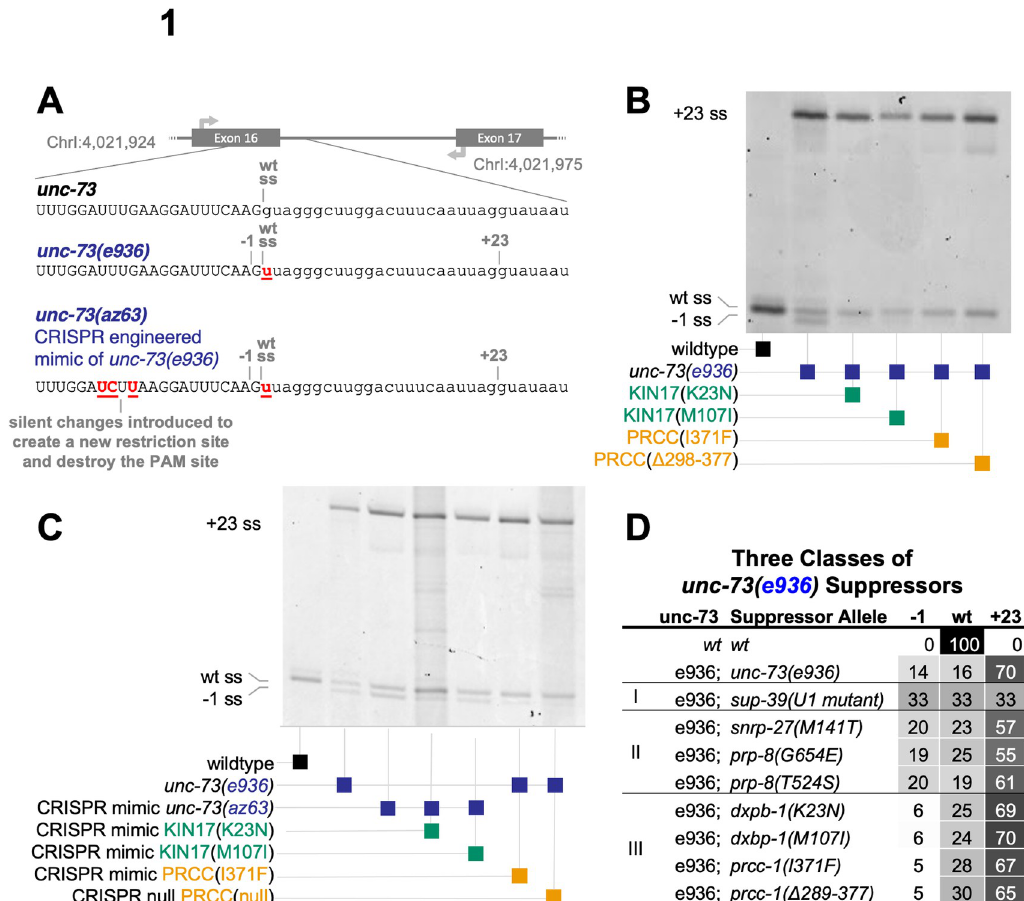
Fig 1. Mutations in KIN17/dxbp-1 and PRCC suppress cryptic splicing, promoting an unusual /UU 5’ splice site. (A) Schematic diagram of the 16th intron of the C . elegans gene unc-73 , showing genomic coordinates and relative loci of splice sites and PCR primer locations used to assess splice site usage. Below, aligned sequences of the unc-73 sequence and exon/intron boundary in wild type, unc-73(e936) , and in the CRISPR engineered allele unc-73(az63) . The cryptic splice sites activated in the competition assay are labeled -1 and +23 and define introns beginning with /GU that are both out of frame. Note that the wild- type splicing position is still denoted “wt ss” even though that intron now begins /UU. The slash mark (/) denotes the splice site. (B) Poly-acrylamide gel showing Cy-3 labeled unc-73 PCR products amplified from unc-73 cDNA. RNA was extracted from plates of the following 6 mixed-stage strains of C . elegans : wild-type N2, unc-73(e936) , and four independent original suppressed strains identified in the genetic screen whose genotypes are indicated below, each bears both the unc-73(e936) allele and an extragenic suppressor of both the movement defect. The same PCR primers are used on all samples; band positions and intensities are indicative of relative use of the three available 5’ splice sites, labeled -1, wt, and +23. Strains are, in lane order, N2, SZ181, SZ162, SZ283, SZ280, and SZ281, see Methods for genetic details. (C) Putative suppressor identities were verified by de novo recreations of mutations using CRISPR/Cas9 and homology-directed repair into unc-73 reporter strains. Image is a scan of a denaturing polyacrylamide gel showing Cy-3 labeled unc-73 PCR products from unc-73 cDNA. RNA was extracted from mixed-stage strains with the indicated unc-73 , dxbp-1 , and prcc-1 alleles shown below. Strains are, in lane order, N2, SZ181, SZ219, SZ391, SZ222, SZ308, SZ348, see Methods for genetic details. Unless otherwise mentioned, CRISPR-engineered mimic alleles are used for all subsequent experiments and figures in this report. (D) Four new suppressors of cryptic splicing represent a new class of suppressors, with a distinct molecular phenotype compared to previously identified suppressors. Indicated are the suppressor class (I, II, or III) [16,17,20], genotype of unc-73 , genotype of suppressor, average percent spliced in (PSI), n � 3, at the /GU splice site at position -1 relative to wild type, average PSI at /UU splice site in wild-type position, and average PSI at the /GU at position +23. Conditional grayscale shading highlights patterns in numerical data. All 4 Type III suppressors have a statistically significant difference in usage of the -1 splice site when compared to all of the Type II suppressors, p < 0.01 by Student’s T-Test. (S1 Table). Note that the values in 1D for Type II suppressors and control vary slightly from previous publications, but the trends are all consistent. This variation may be due to the use of the new Cy-3-labeled primer assay, see